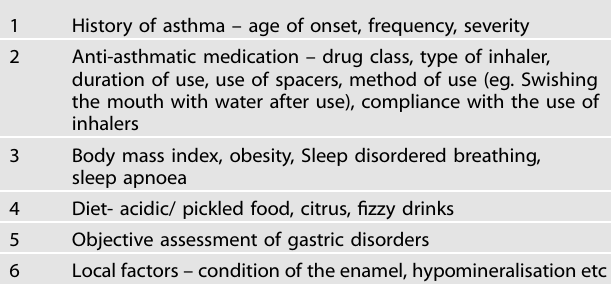
Table 5. Checklist for dentist when treating patients with